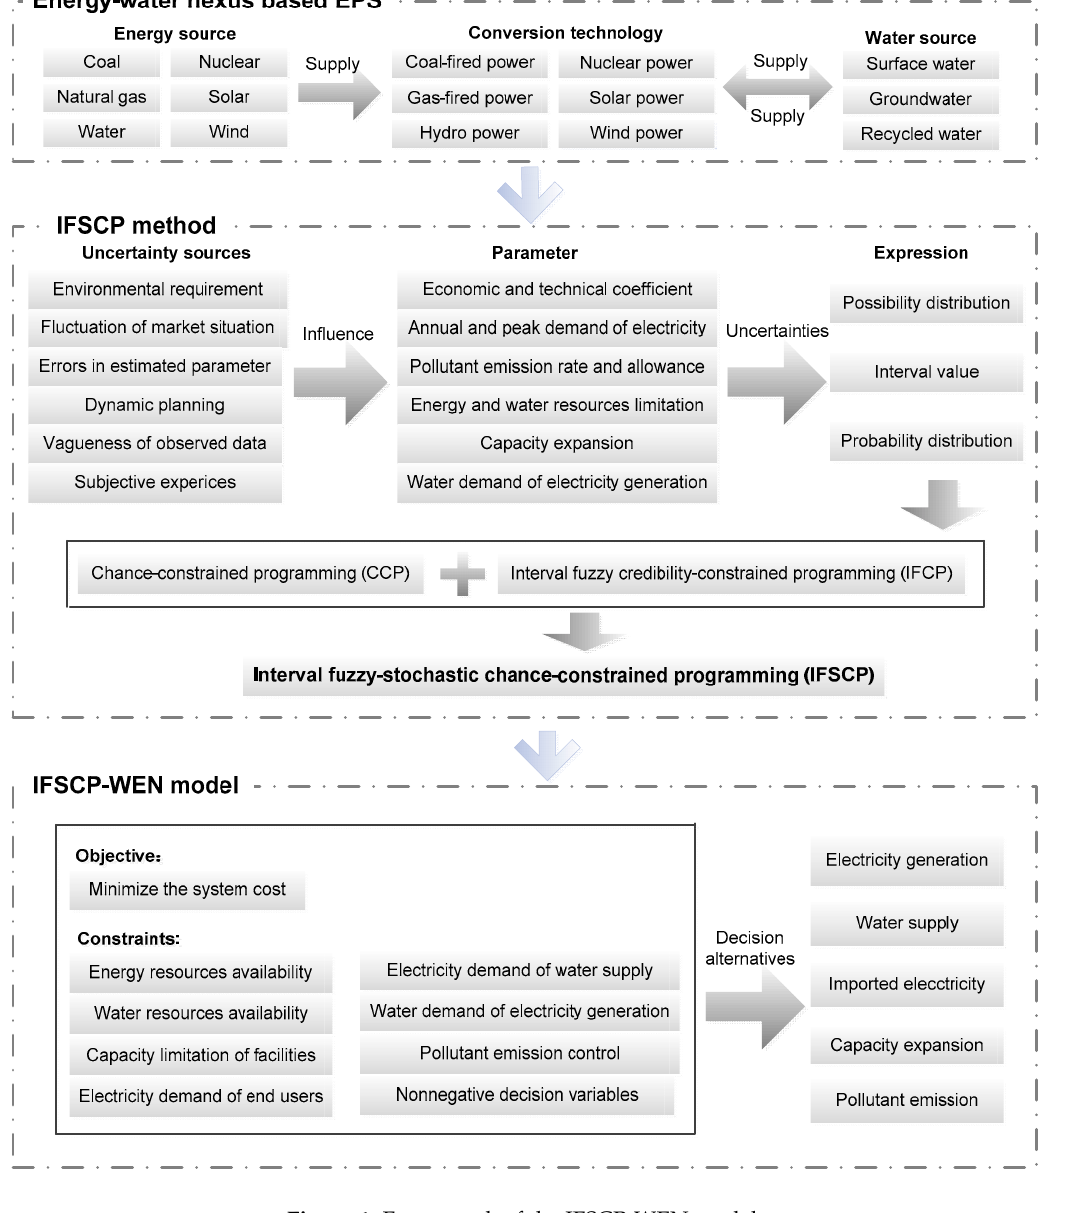
Figure 1. Framework of the IFSCP-WEN model.